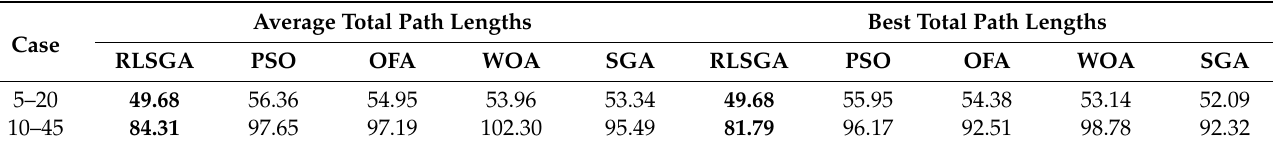
Table 3. Algorithm-running results comparison.